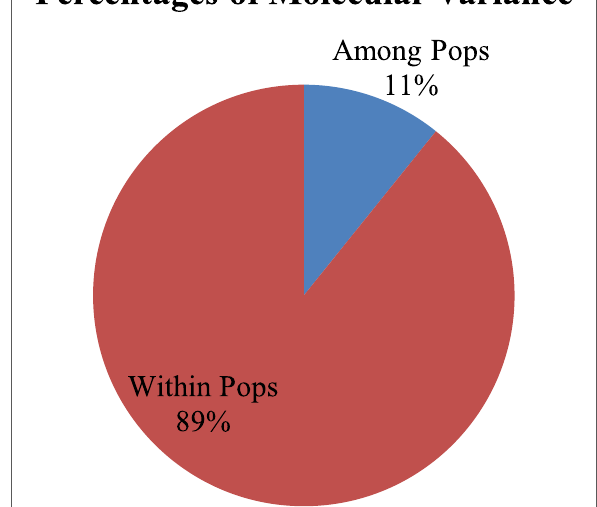
Fig. 3 Analysis of molecular variance (AMOVA) performed among the 54 Capsicum accessions